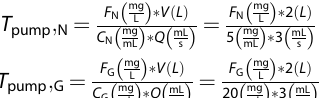
F N : Nitrate demand every 8 hours ð mg = L Þ Dark cycles . For the dark cycles, three model equations were built to predict biomass accumulation rate, nitrate consump- tion rate and glucose consumption rate as listed below and shown in Fig. 3b. In the biomass equation, we assumed a fraction of heterotrophic biomass, a , was derived from autotrophic metabolism and the simulated growth rate was μ A . Meanwhile, some biomass was derived through hetero- trophic metabolism with the simulated growth rate, μ H. The nutrient exchange rates ( r NA , r NH , r GH ) were determined by